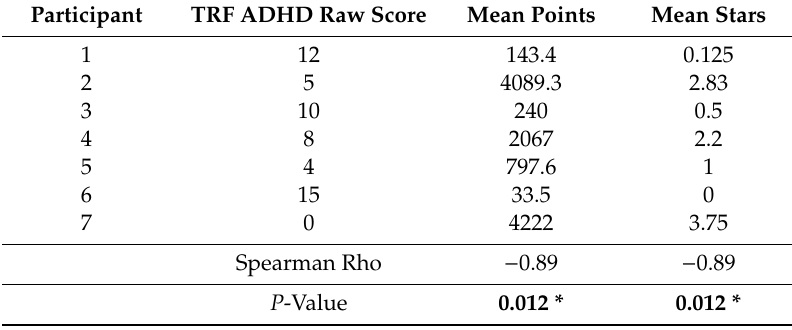
Table 3. Mean Participant Teacher Report Form (TRF) attention-deficit / hyperactivity disorder (ADHD) Raw Score vs In-game Performance (Points & Stars